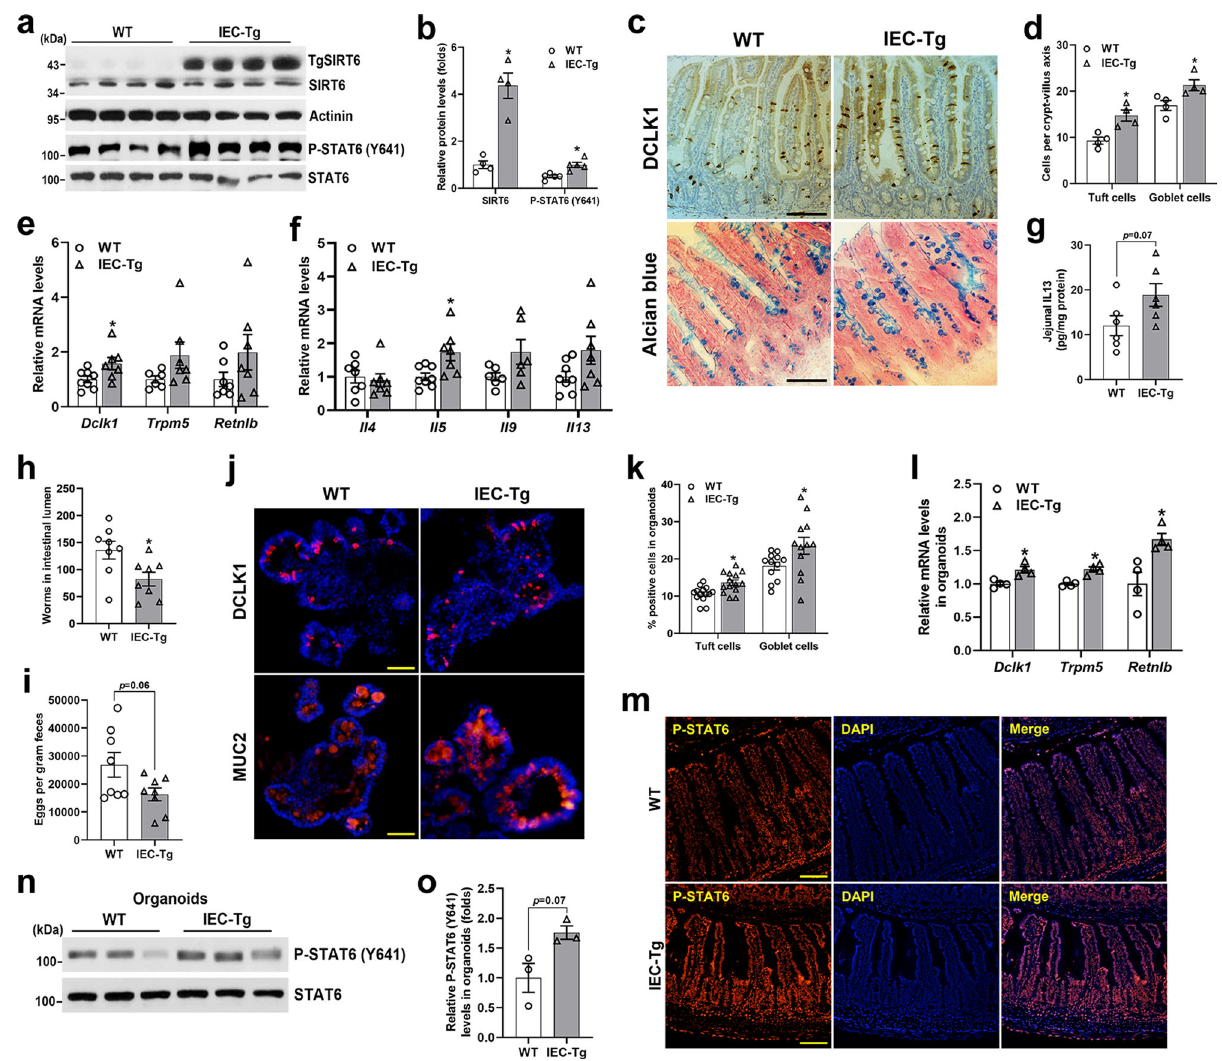
Fig. 7 | IEC overexpression of SIRT6 elevates the Tyr641 phosphorylation of STAT6andenhancesanti-helminthresponses. 3-month-oldmaleWTandIEC-Tg mice were infected with H. poly and subjected to the following analyses on day 14 post-infection. a , b Western blot ( a ) and quanti fi cation ( b ) analyses of SIRT6 and P-STAT6 (Y641) in the jejunal IECs. n =4 mice/group (SIRT6) and 5 mice/group (P- STAT6); p =0.0057 (SIRT6, P-STAT6). c Tuft and goblet cells were examined by DCLK1 immunostaining and Alcian blue staining, respectively in the jejunum (200X). d Quanti fi cation of tuft and goblet cellsshown in ( c ). n =4 mice/group;20 crypt-villus units counted for each mouse; p =0.0118 (tuft cell) and 0.0338 (goblet cell). e qPCR analysis of tuft and goblet cell markers expression in the jejunal IECs. Dclk1 ,n=8(WT)and7(IEC-Tg)mice; Trpm5 , n =6(WT)and7(IEC-Tg)mice; Retnlb , n =7 mice/group; p =0.0489 ( Dclk1 ). f qPCR analysis of type 2 immune cytokine genes expression in the jejunum. Il4 , n =7 mice/group; Il5 , Il13 , n =8 (WT) and 7 (IEC-Tg) mice; Il9 , n =6 mice/group; p =0.028 ( Il5 ). g Jejunal IL13 levels were